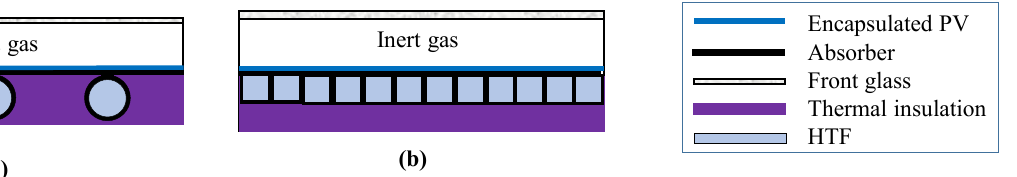
Figure 3. Basic liquid-based PV-T collector designs: ( a ) sheet-and-tube and ( b ) flat-box channel. (Adapted with permission from [26]. Copyright 2009 Elsevier Ltd.).